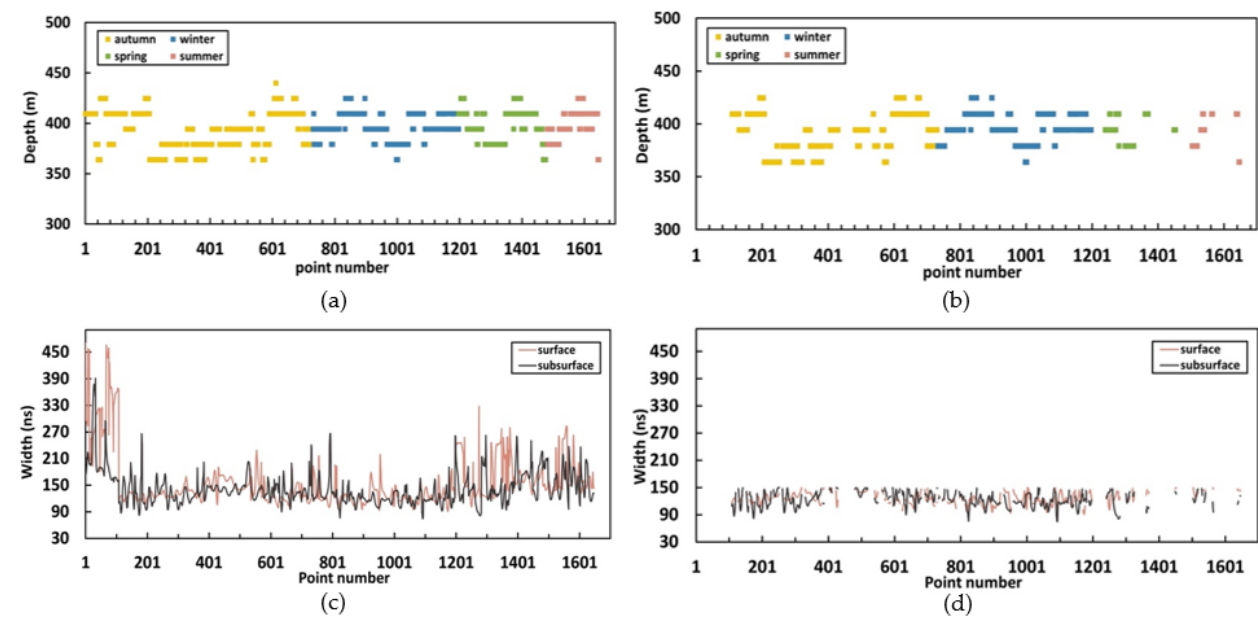
Figure 5. The thickness of shallow deposits in the south polar area and the echo’s width of the subsatellite point before and after filtering data in S2: ( a , b ) show the thickness of AA 3c before and after data filtering, respectively. Data of different Martian seasons are indicated by different colors. ( c , d ) the width of the echo at 3dB before and after filtering the data, respectively. The red line represents the width of the surface echo, and the black line represents the width of the subsurface echo. Corresponding data in S1 and S3 can be found in the TABLE(Figure S2).